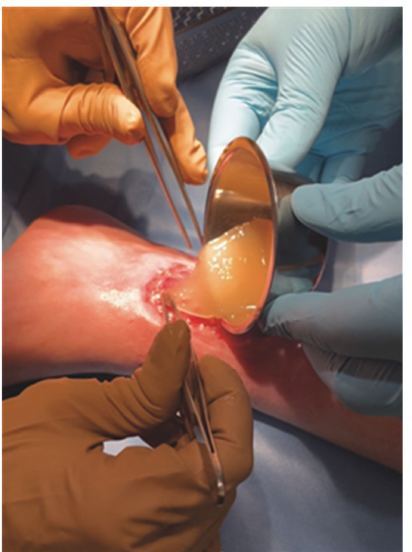
Figure 5. PRP-HA gel applied on a disinfected wound as a biological